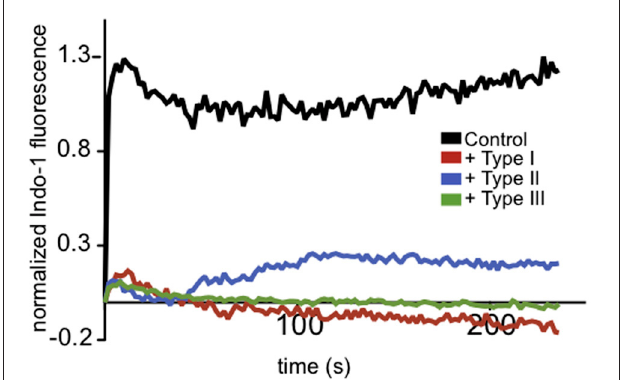
FIGURE 1 | T. gondii- infected neutrophils exhibit reduced Ca 2 + responses to fMLP. Representative indo-1 fluorescence measurements of Ca 2 + responses to 10 μ M fMLP, added at t = 0, in control (black), Type I (red), Type II (blue), or Type III (green) infected cells (MOI